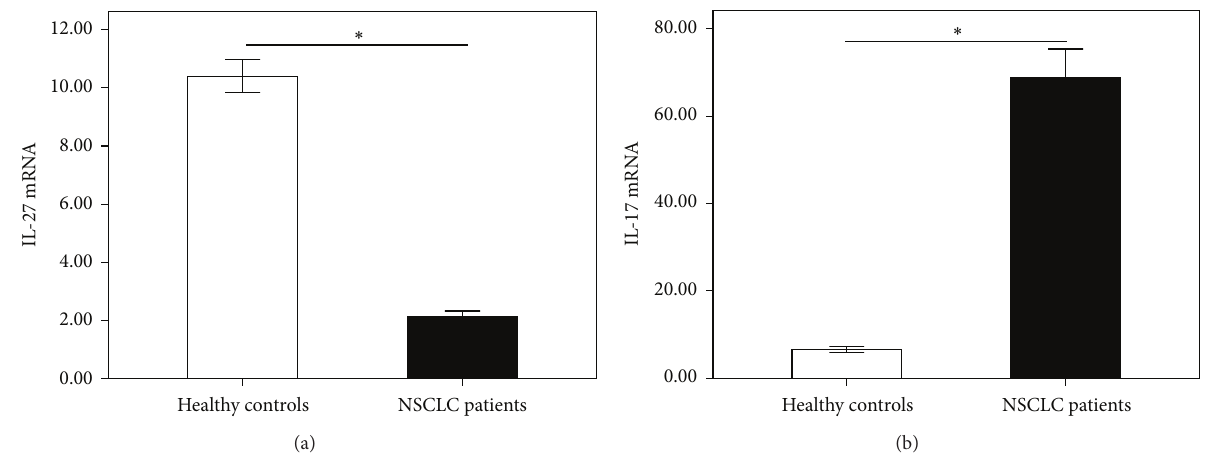
Figure 2: The mRNA expressions of IL-27 and IL-17 in peripheral blood were measured by using QPCR. The mRNA levels of IL-27 (a) were significantly lower in NSCLC patients than in healthy controls. IL-17 mRNA levels (b) were significantly higher in NSCLC patients than in healthy controls. Results are expressed as pg/mL (mean ± SD). 𝑛 = 19 ; ∗ 𝑃 < 0.001